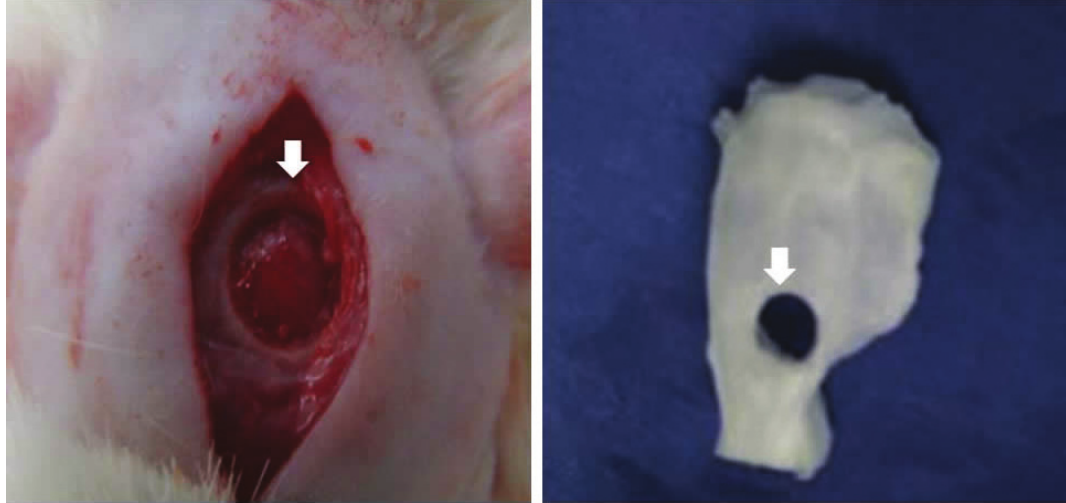
Figure 1. Upper view of the rat skull showing the experimentally created parietal bone defect